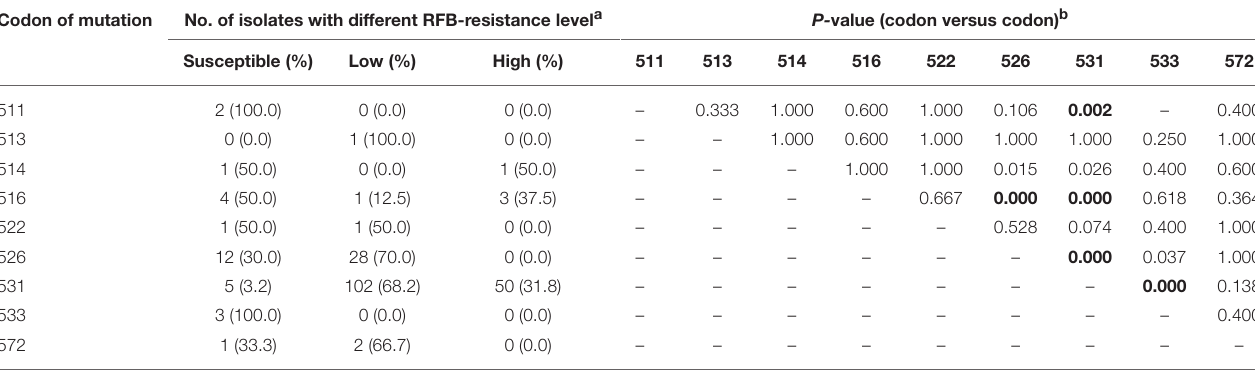
TABLE 4 | Distribution of MTB isolates with different RFB-resistance level. Codon of mutation No. of isolates with different RFB-resistance level a P- value (codon versus codon)